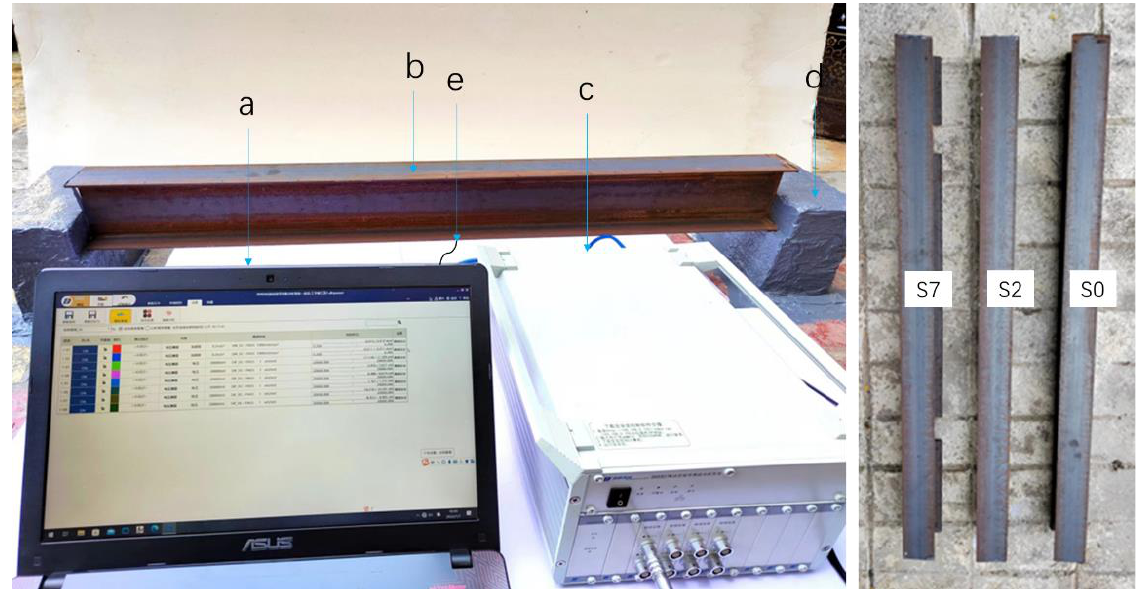
Figure 11. Process of experimental arrangement: ( a ) Laptop. ( b ) Simple supported steel beam. ( c ) DH5927N dynamic signal test and analysis system. ( d ) Brick cement bearing. ( e ) Piezoelectric acceleration sensor.